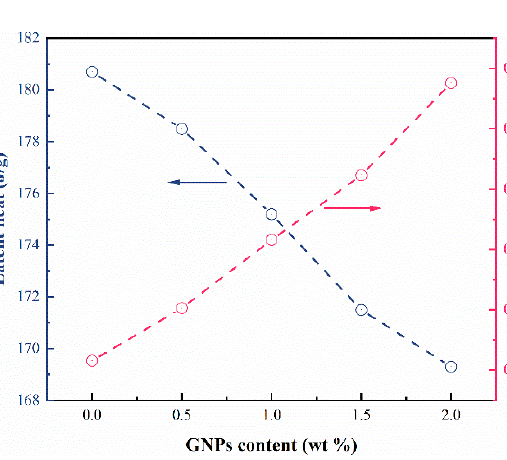
Table 2. Calculated and measured values of the melting latent heat of composites.